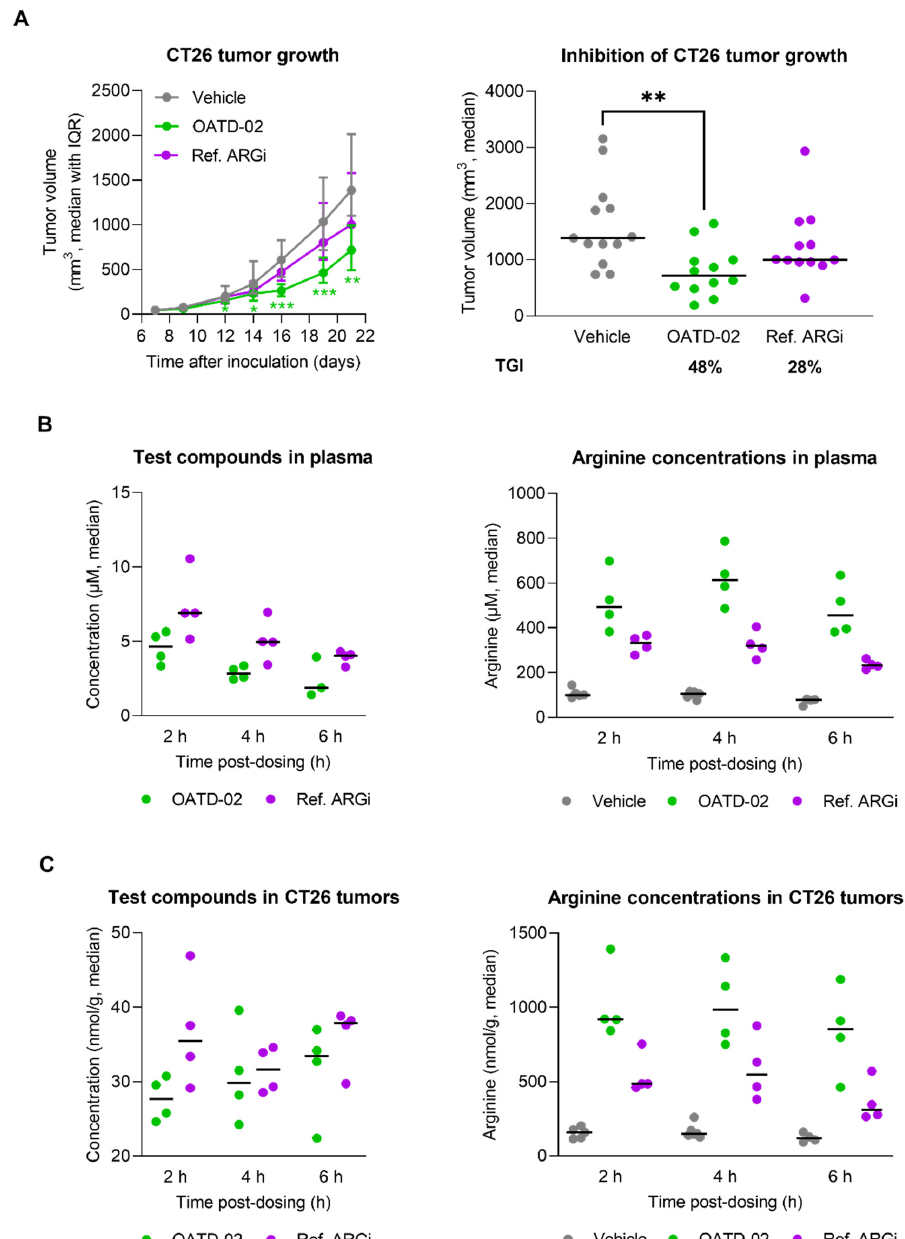
Figure 2. OATD-02 significantly reduces the growth of syngeneic CT26 tumours (colorectal carci- noma) in immunocompetent mice. ( A )—BALB/c mice were inoculated with CT26 cells and upon 24 h dosed with OATD-02 (100 mg/kg, PO, BID) or Ref. ARGi (100 mg/kg, PO, BID) till the end of the experiment; the final tumour measurements were shown in the right graph (* 0.0281 < p < 0.0303, ** p = 0.0033, *** 0.0007 < p < 0.0008; Kruskal–Wallis test with Dunn’s multiple comparisons test). ( B )—the concentrations of test compounds in plasma and corresponding L -arginine concentrations. ( C )—the concentrations of test compounds in tumour homogenates and corresponding L -arginine concentrations.